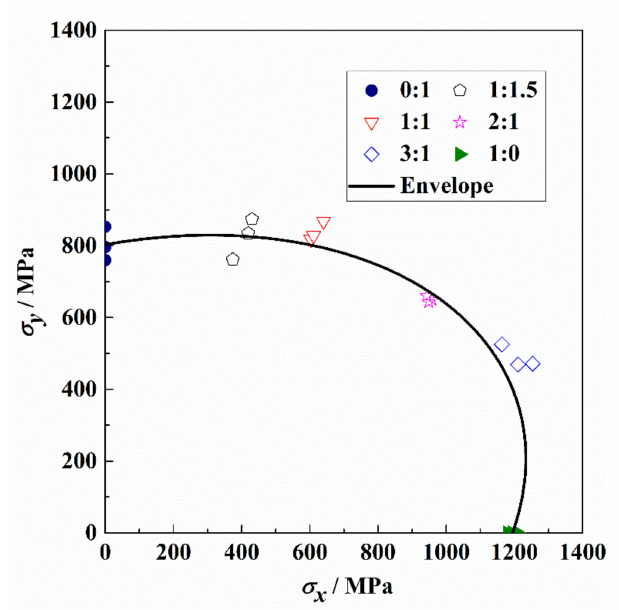
Figure 13. The tension–tension failure